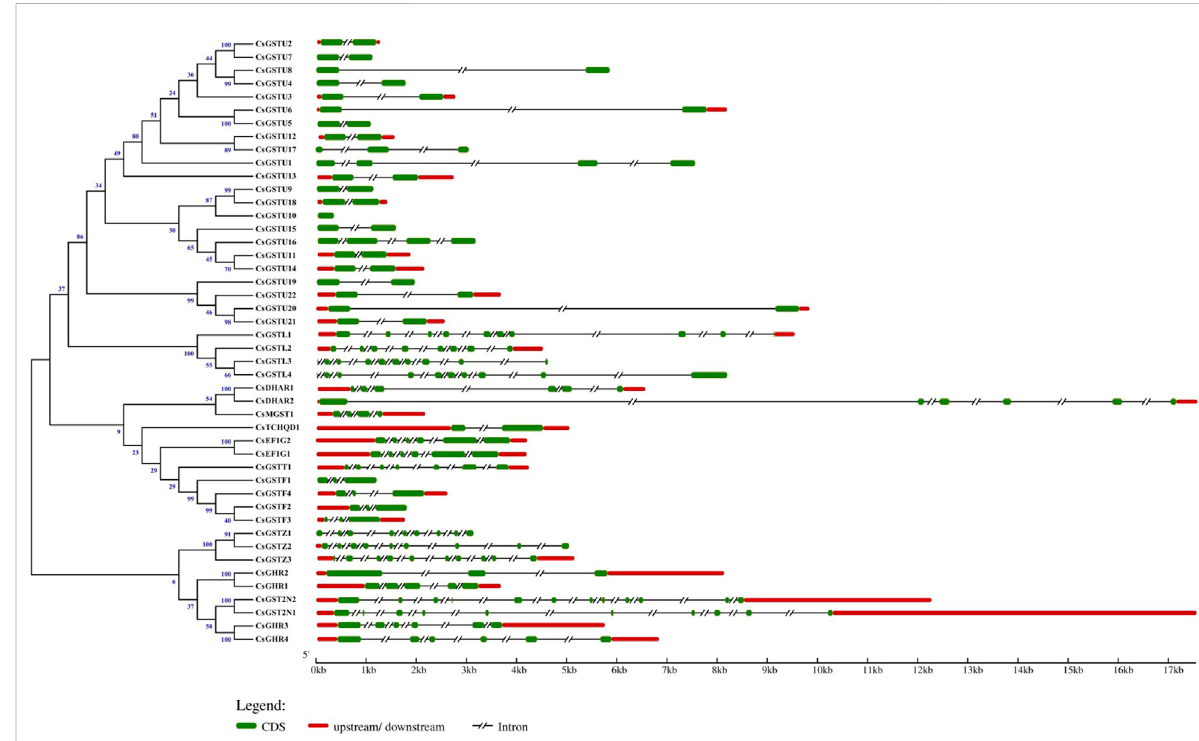
FIGURE 1 Relationship of the GST family genes in cucumber and their structure. Phylogenetic tree of the 46 identi fi ed GST genes and their structures. Exons, introns, and their upstream/downstream regions are represented by green boxes, black lines, and red boxes, respectively. The scale on the bottom shows the relative lengths of transcripts, exons, and introns in kilobase pairs